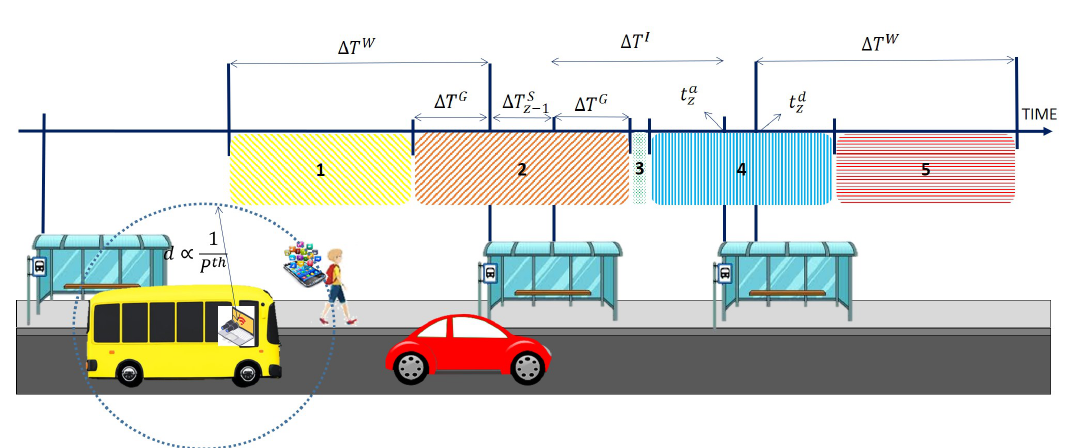
Figure 5. Counting problem and